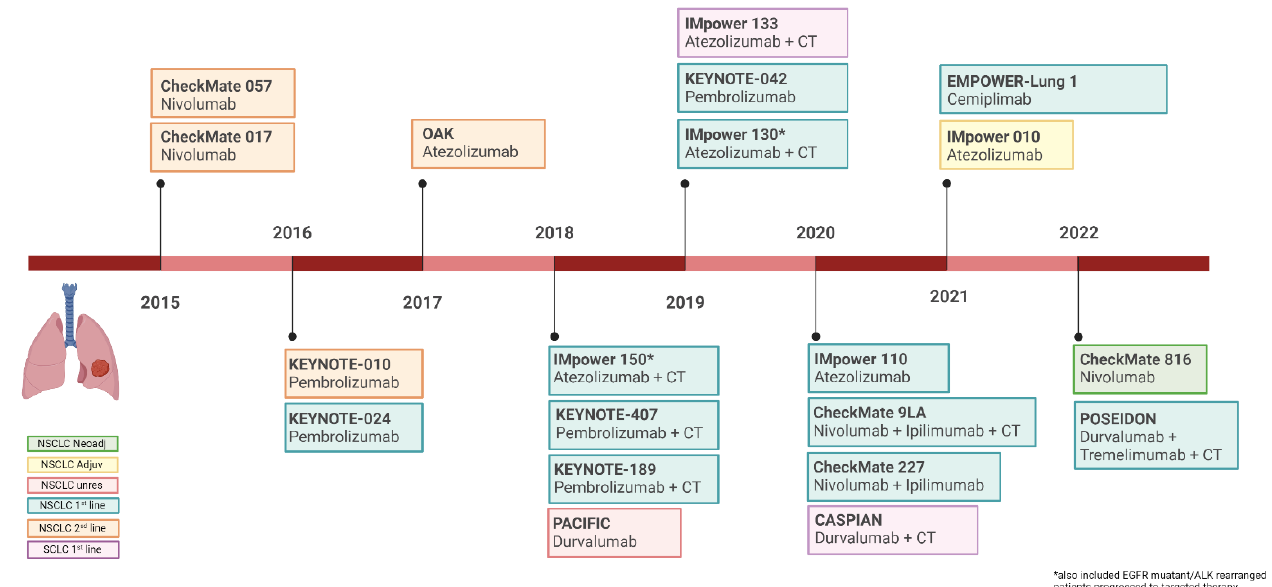
Figure 1. Timeline of Food and Drug Administration approval of immune checkpoints inhibitors in lung cancer. Image created with BioRender.com, accessed on 5 July 2022.